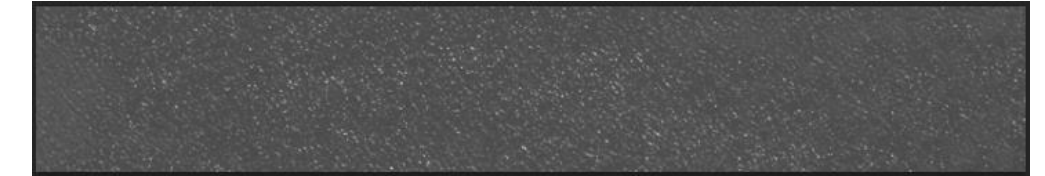
Figure 17. The image with the minimum compression ratio (dynamic Yangtze River).